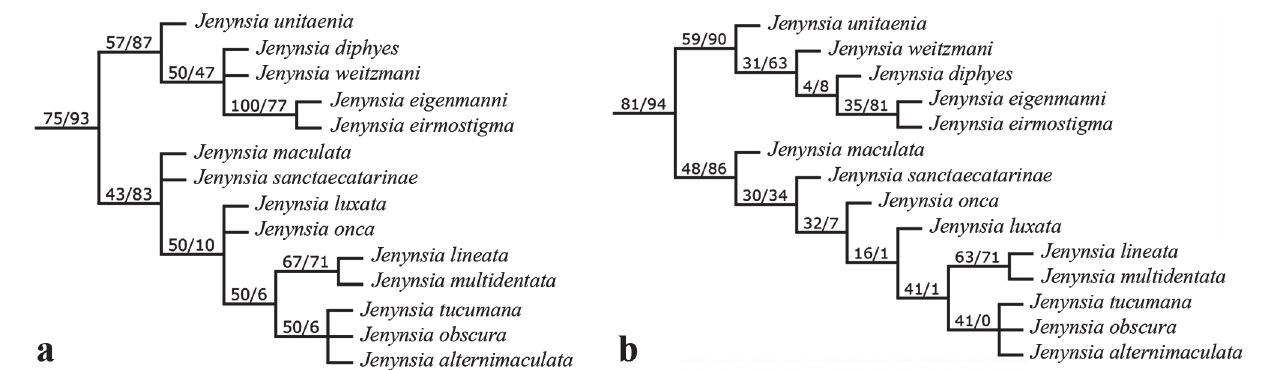
Fig. 5. Topologies from most equally parsimonious trees and relative Bremer support/GC values under ( a ) equal weights (strict consensus of 12 trees), and ( b ) implied weighting (strict consensus of two trees), with concavities K = 4 to 20 (with supports measured under K = 8). Unsupported nodes are shown as collapsed. The relationships of genera of the family are consistent with those proposed in previous studies, therefore species of Anableps and Oxyzygonectes are not